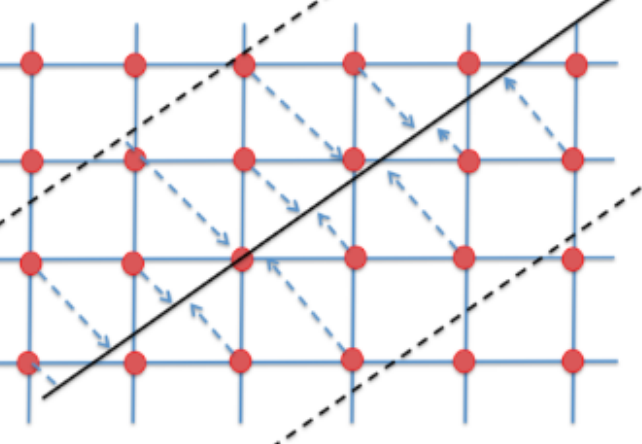
Figure 1. Construction of a one-dimensional quasi-periodic lattice from a higher-dimensional peri- odic